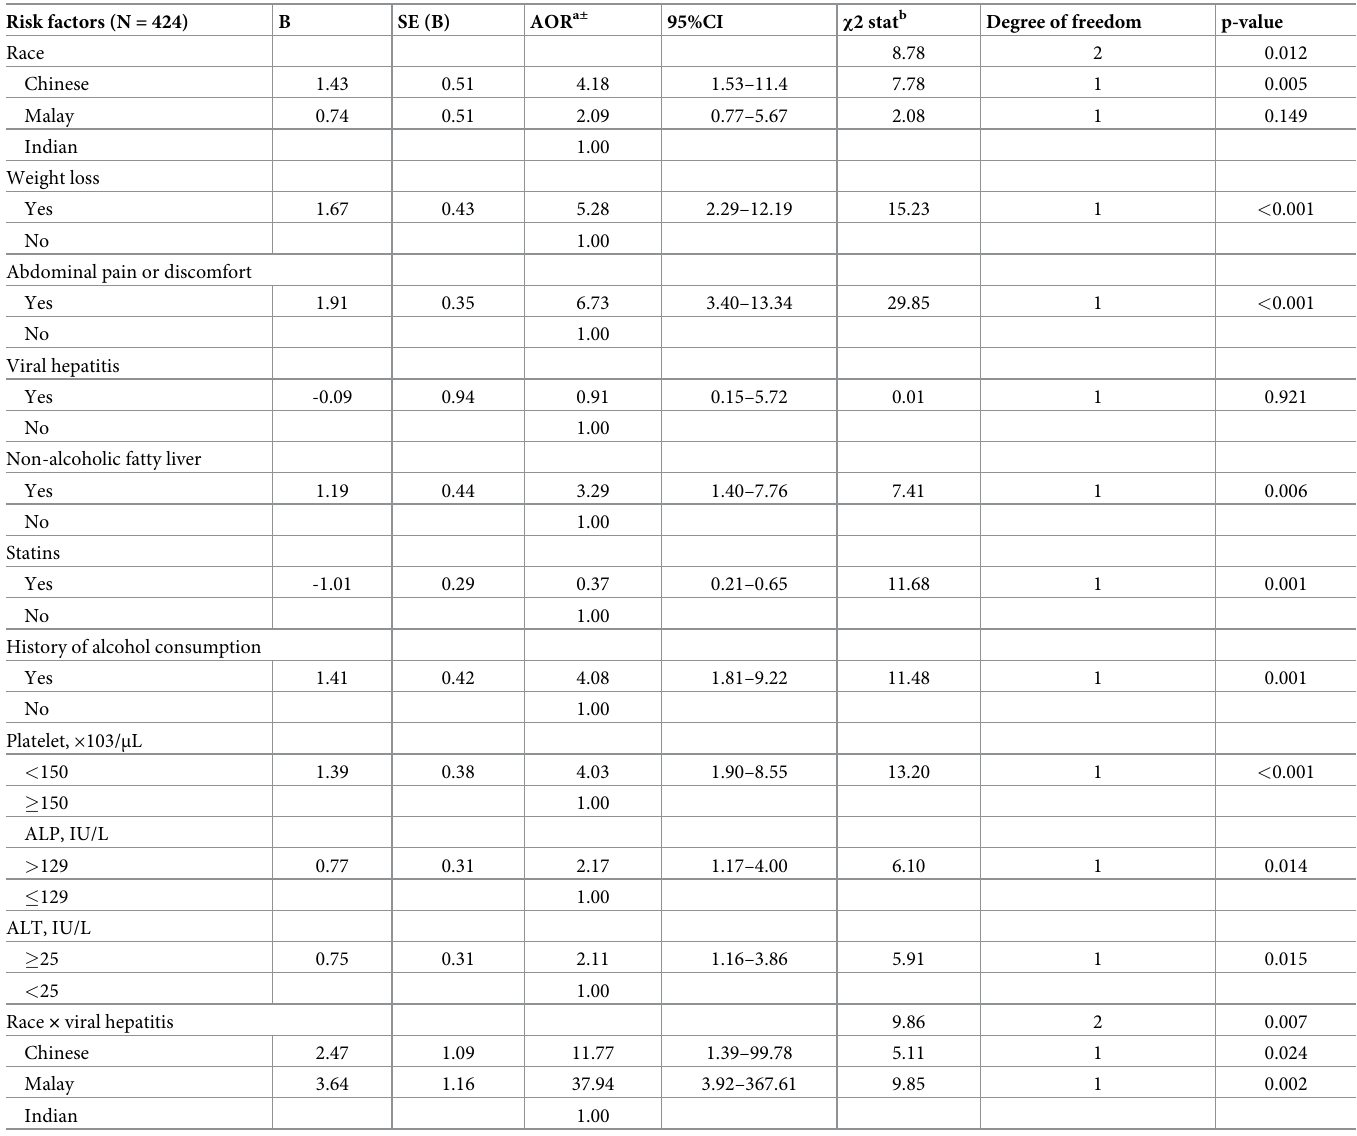
Table 2. Independent factors associated with HCC in T2DM